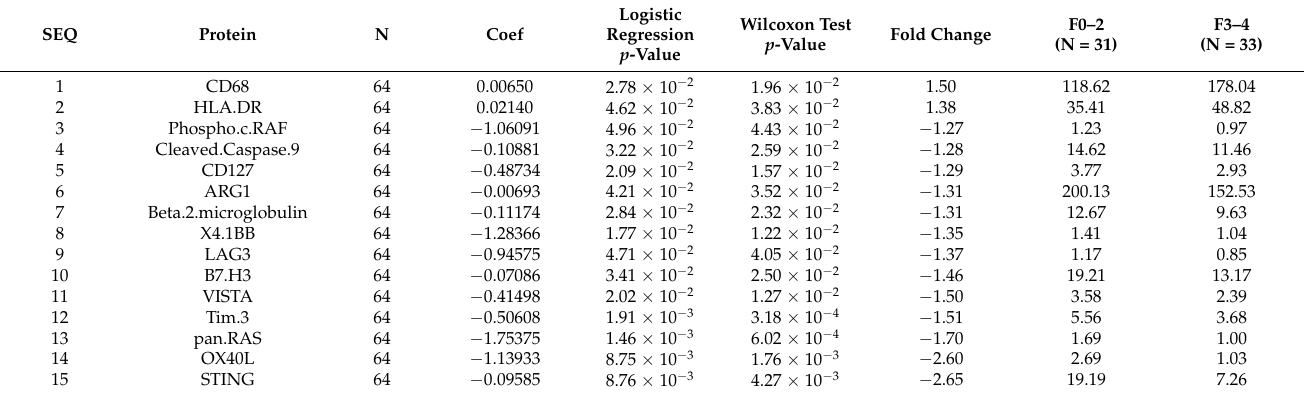
Figure 2. Multiplexed DSP of protein expression level according to the fibrosis stage. ( A ) Represen- tative ROIs according to the fibrosis stage. Each core was stained with CD3 (red), CD68 (yellow), and SMA (green) antibodies. ( B ) Volcano plot describing the differentially expressed proteins in portal CD68 + areas between fibrosis stages 0–2 and stages 3–4. Proteins that are highly expressed in early-stage fibrosis are indicated by red dots (TIM3, pan-RAS, OX40L, and STING), whereas proteins that are highly expressed in advanced stage fibrosis are indicated by blue dots (HLA-DR and CD68). Table 2. List of the differentially expressed proteins according to the fibrosis stages (F0–2 vs.